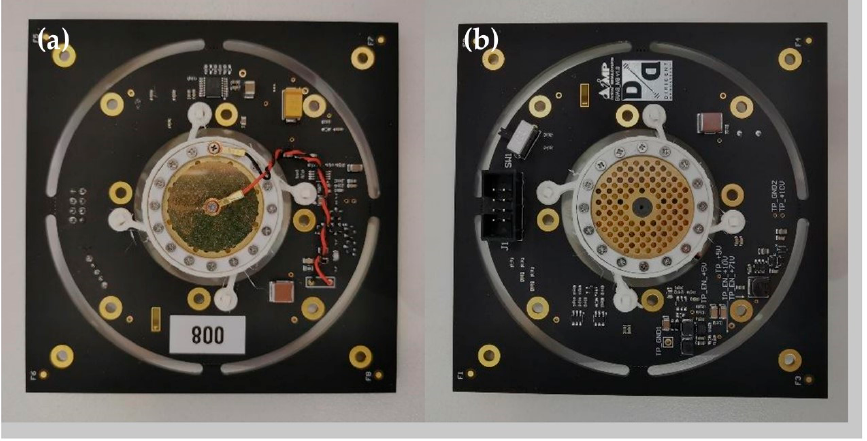
Figure 7. Assembled microphone module: ( a ) front view; ( b ) back view.